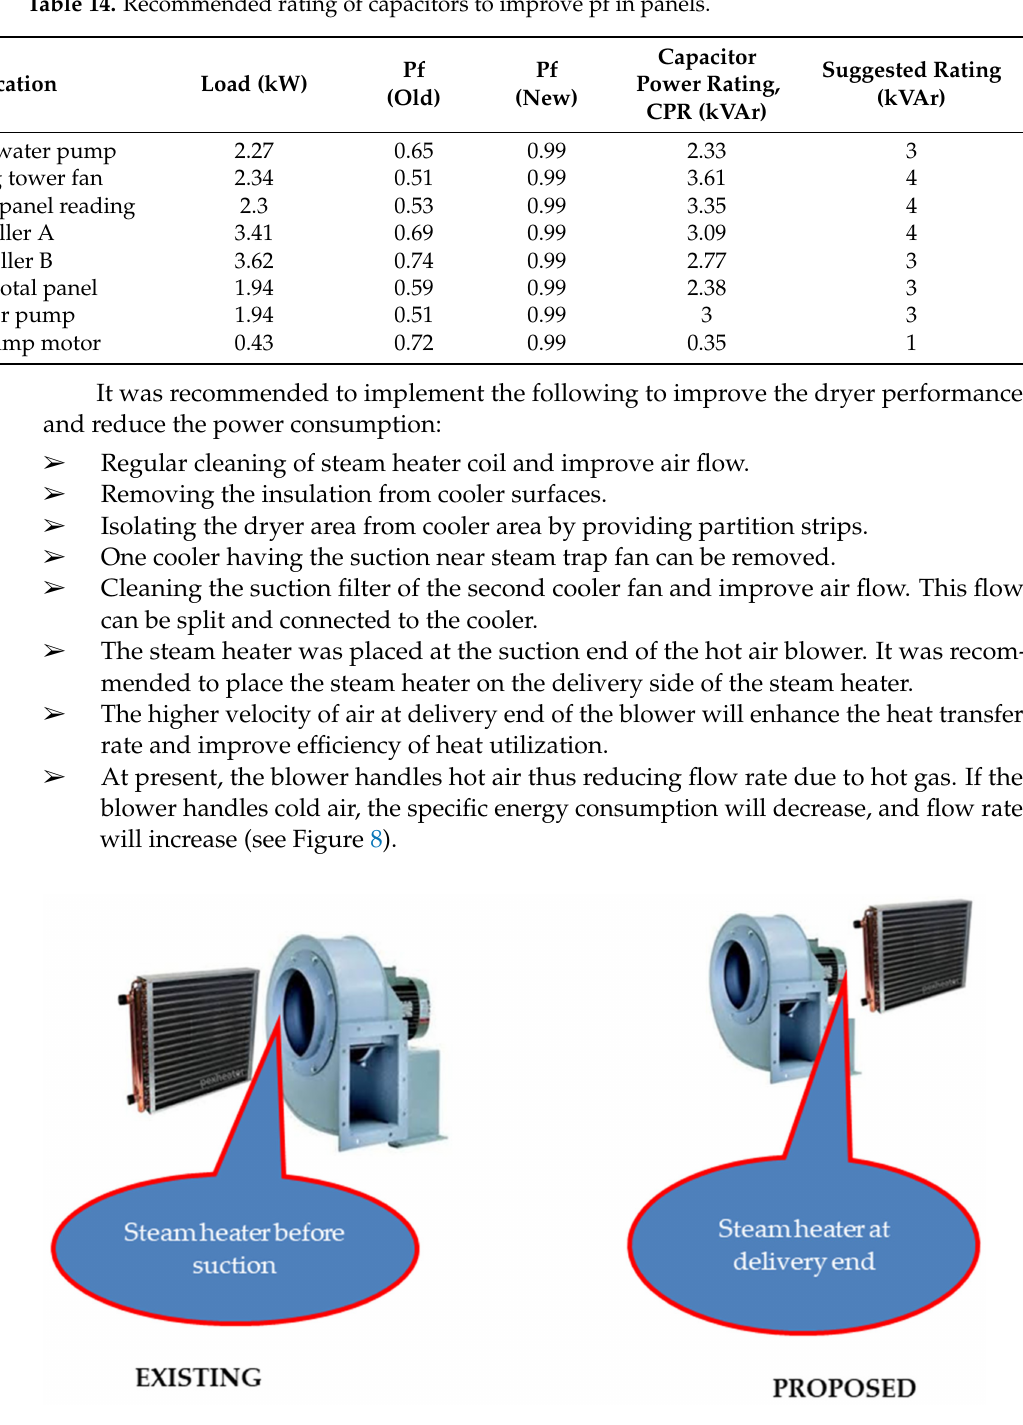
Figure 8. The current and proposed position of heat exchanger to increase the performance. By rectifying the steam heat exchanger arrangement, the hot air temperature could be increased to 90 ◦ C. There is a possibility to increase the drying speed and thus increase the production to 1000 kg/h from the dryer for the same energy consumption. With these measures implemented, one cold air blower would be sufficient to supply cold air and the other blower could be removed as shown in the Figure 9